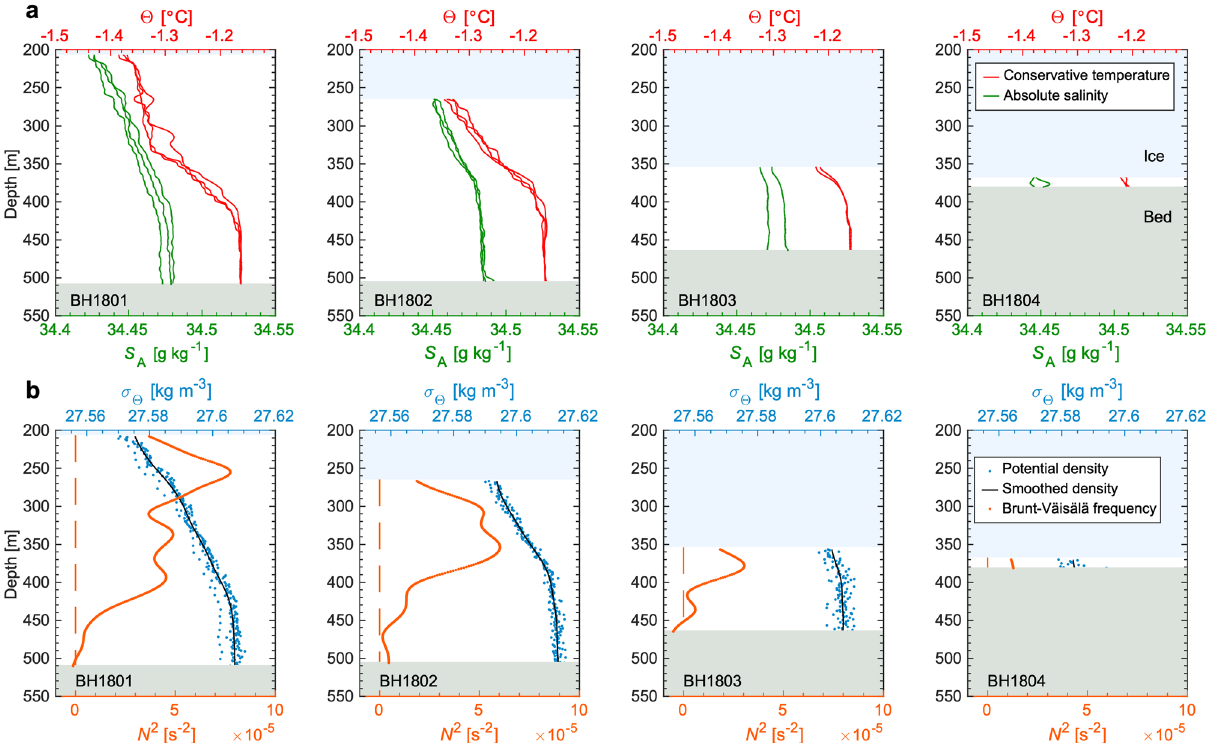
Fig. 3 Subshelf ocean properties. a Conservative temperature, Θ , (red) and absolute salinity, S A , (green) pro fi les measured at the borehole sites. Water properties were measured twice or three times at each site around high and low tides (Supplementary Fig. 2). Light blue and gray shades indicate ice and seabed, respectively. b Potential density, σ Θ , (blue) and the square of Brunt-Väisälä frequency, N 2 , (orange) as means of all measurements at each